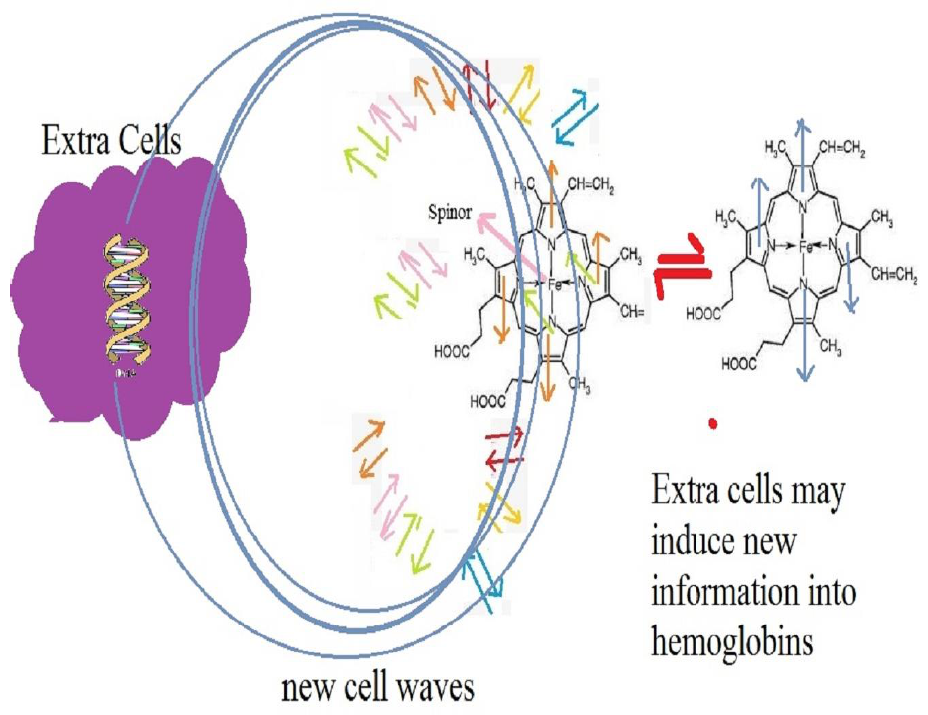
Figure 7. Both T-cells and tumor cells take information sent by heart—a hypothesis.